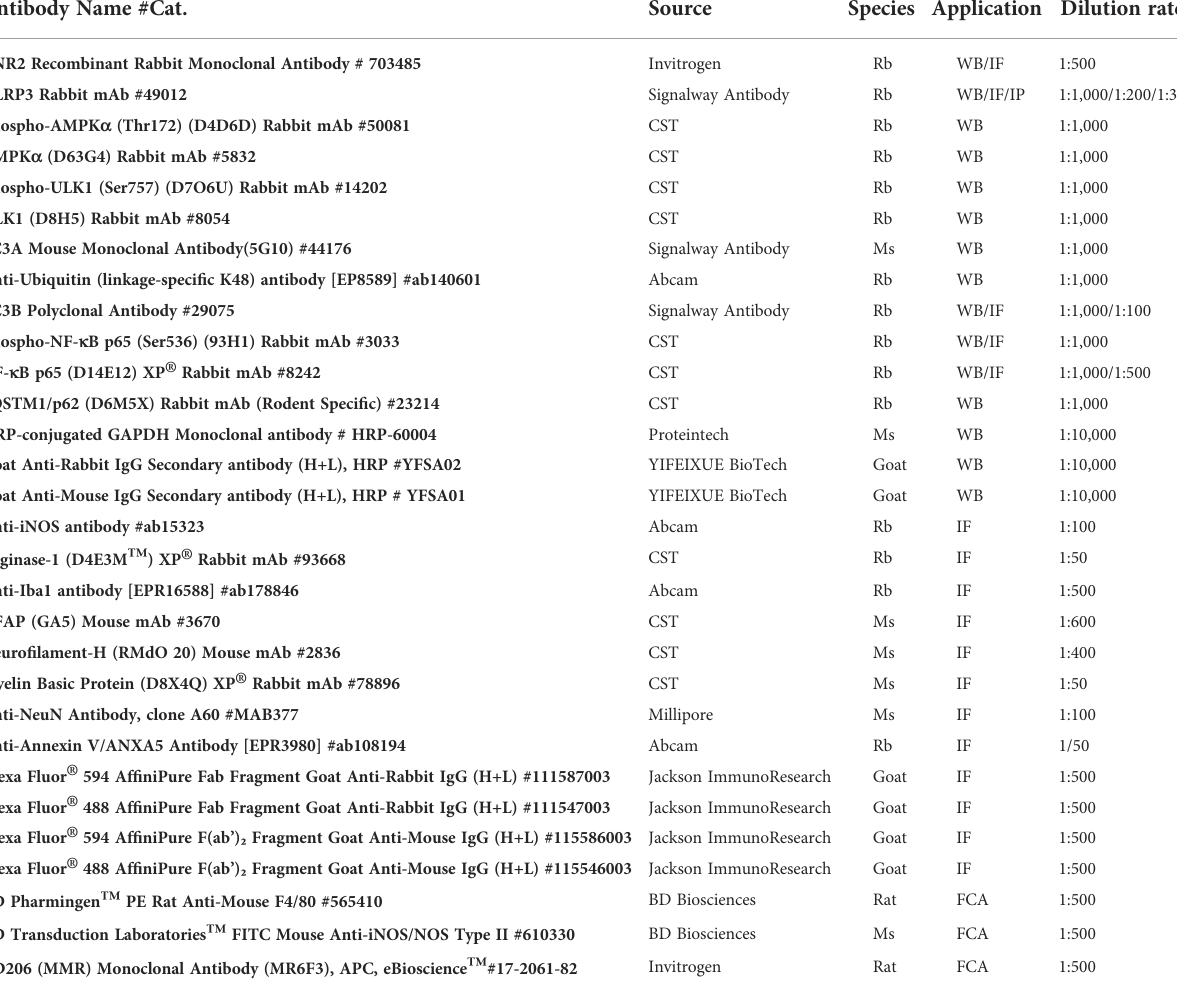
TABLE 1 The information of Abs Antibody Name #Cat. Source Species Application Dilution rate CNR2 Recombinant Rabbit Monoclonal Antibody # 703485 Invitrogen Rb WB/IF NLRP3 Rabbit mAb #49012 Signalway Antibody Rb